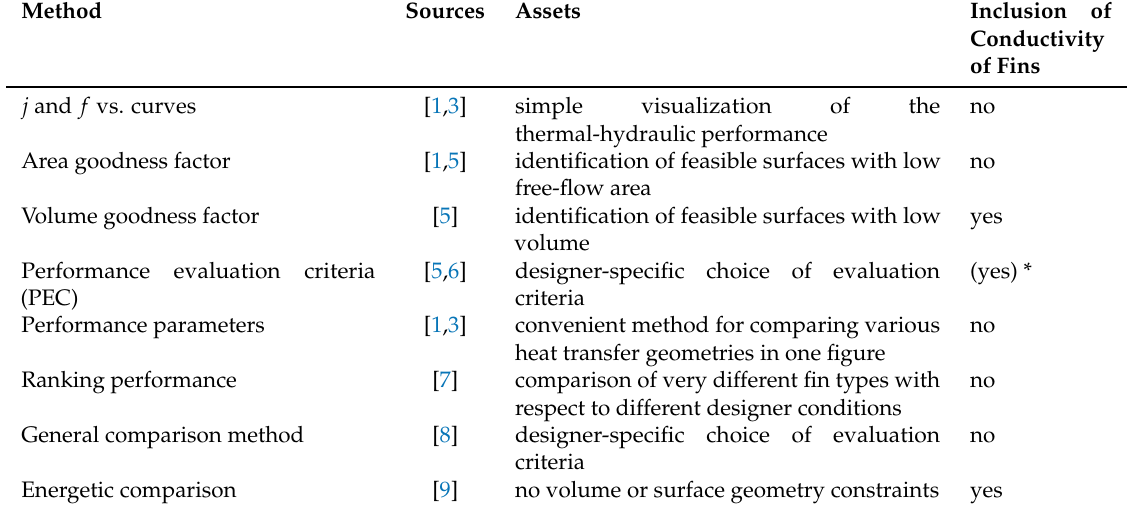
Conductivity of Fins no no yes (yes) * no no no